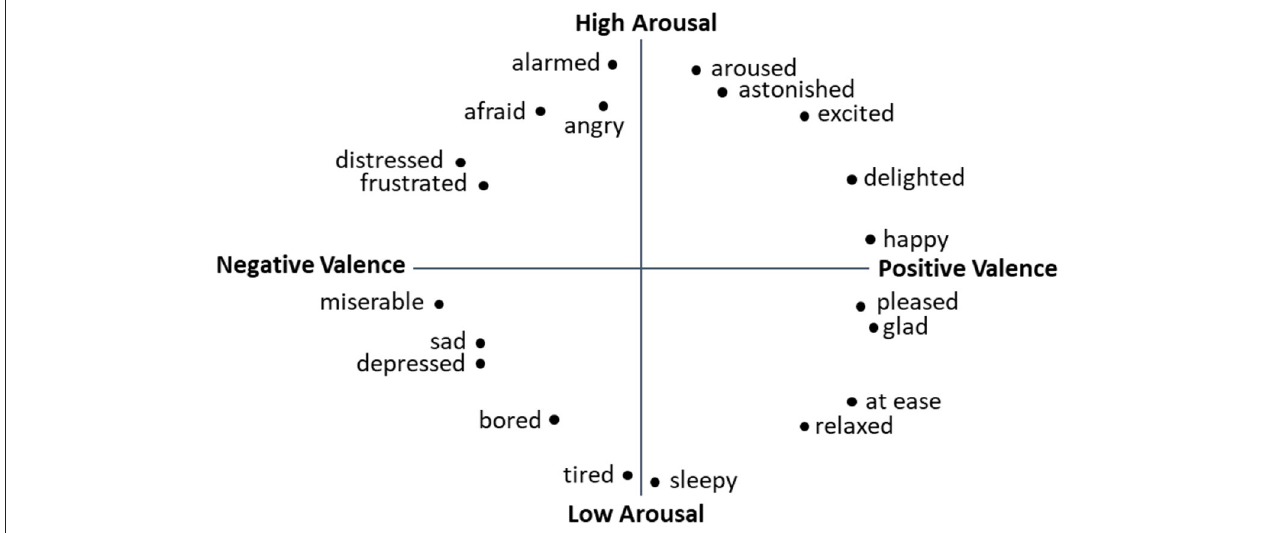
FIGURE 1 | Circumplex Model of Affect (adapted from Russell,